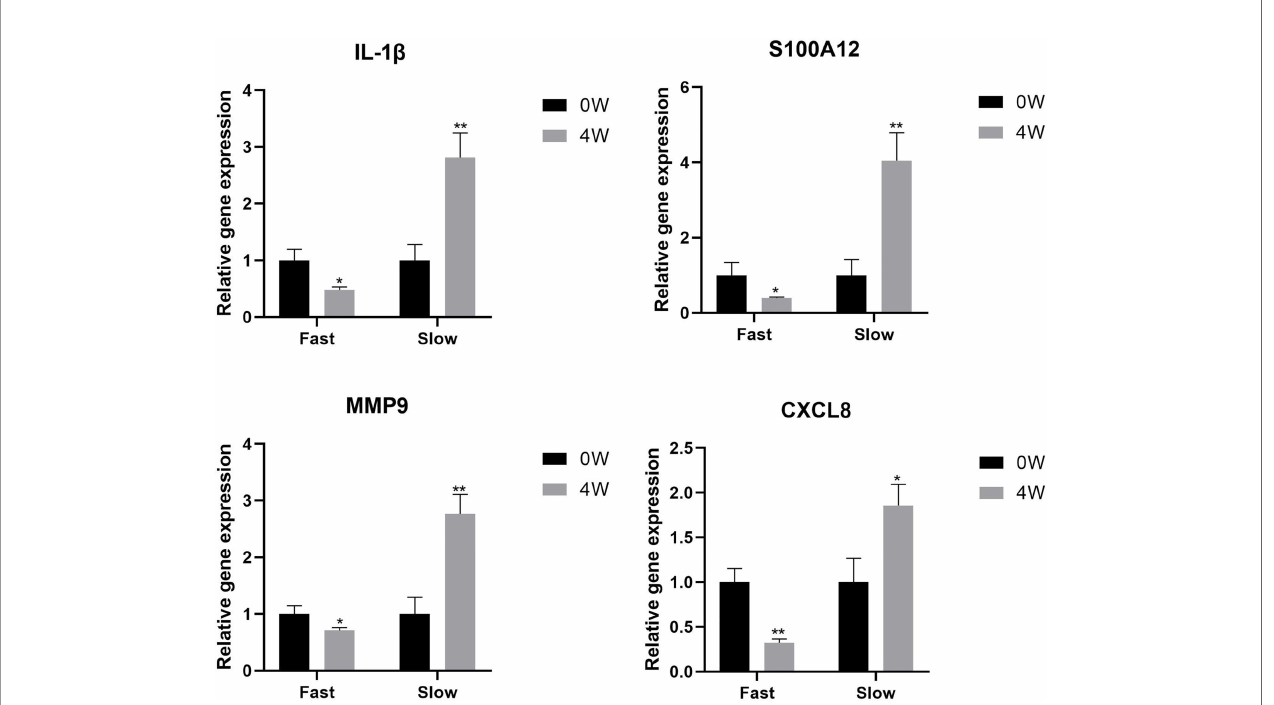
FIGURE 6 | The expression level of IL-1 b , S100A12, MMP9, and CXCL8 genes in 0W and 4W samples from fast responders and slow responders. * P < 0.05, ** P <